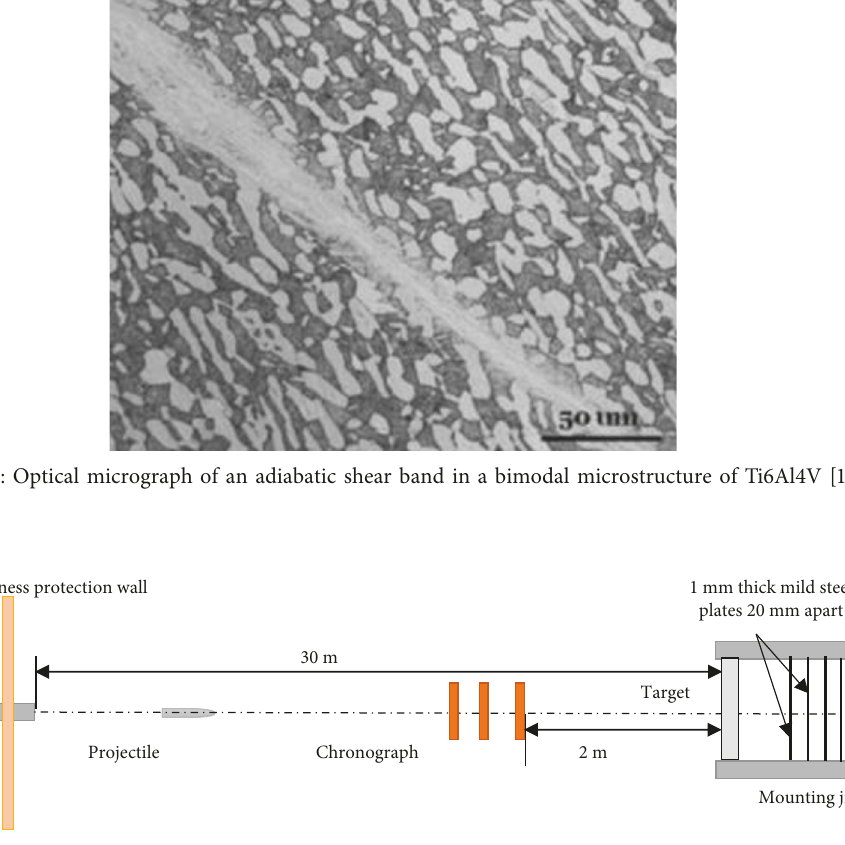
Figure 6: Schematic of the test setup on the Gerotek testing